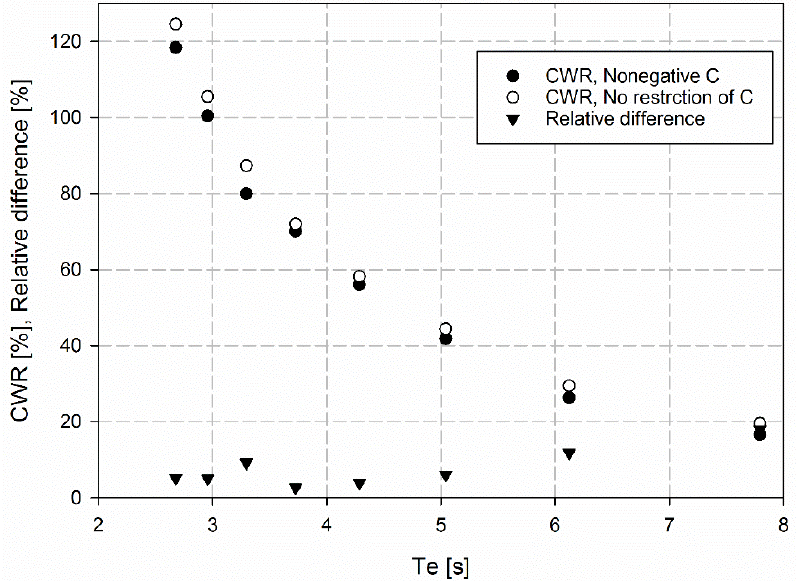
Figure 7. Capture width ratio of the WEC under NPC with or without restriction on the sign of (cid:1829) . The relative difference is defined as relative difference = (CWR1 − CWR2)/CWR2 ×